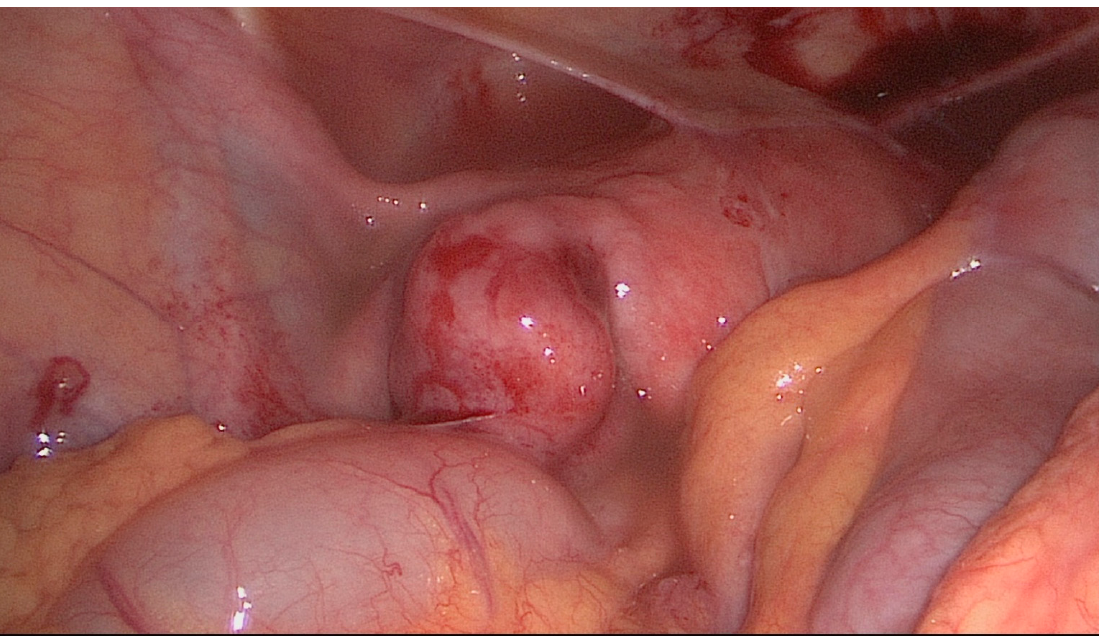
Figure 1. Minor tubal disease according to classification by Hull and Rutherford.